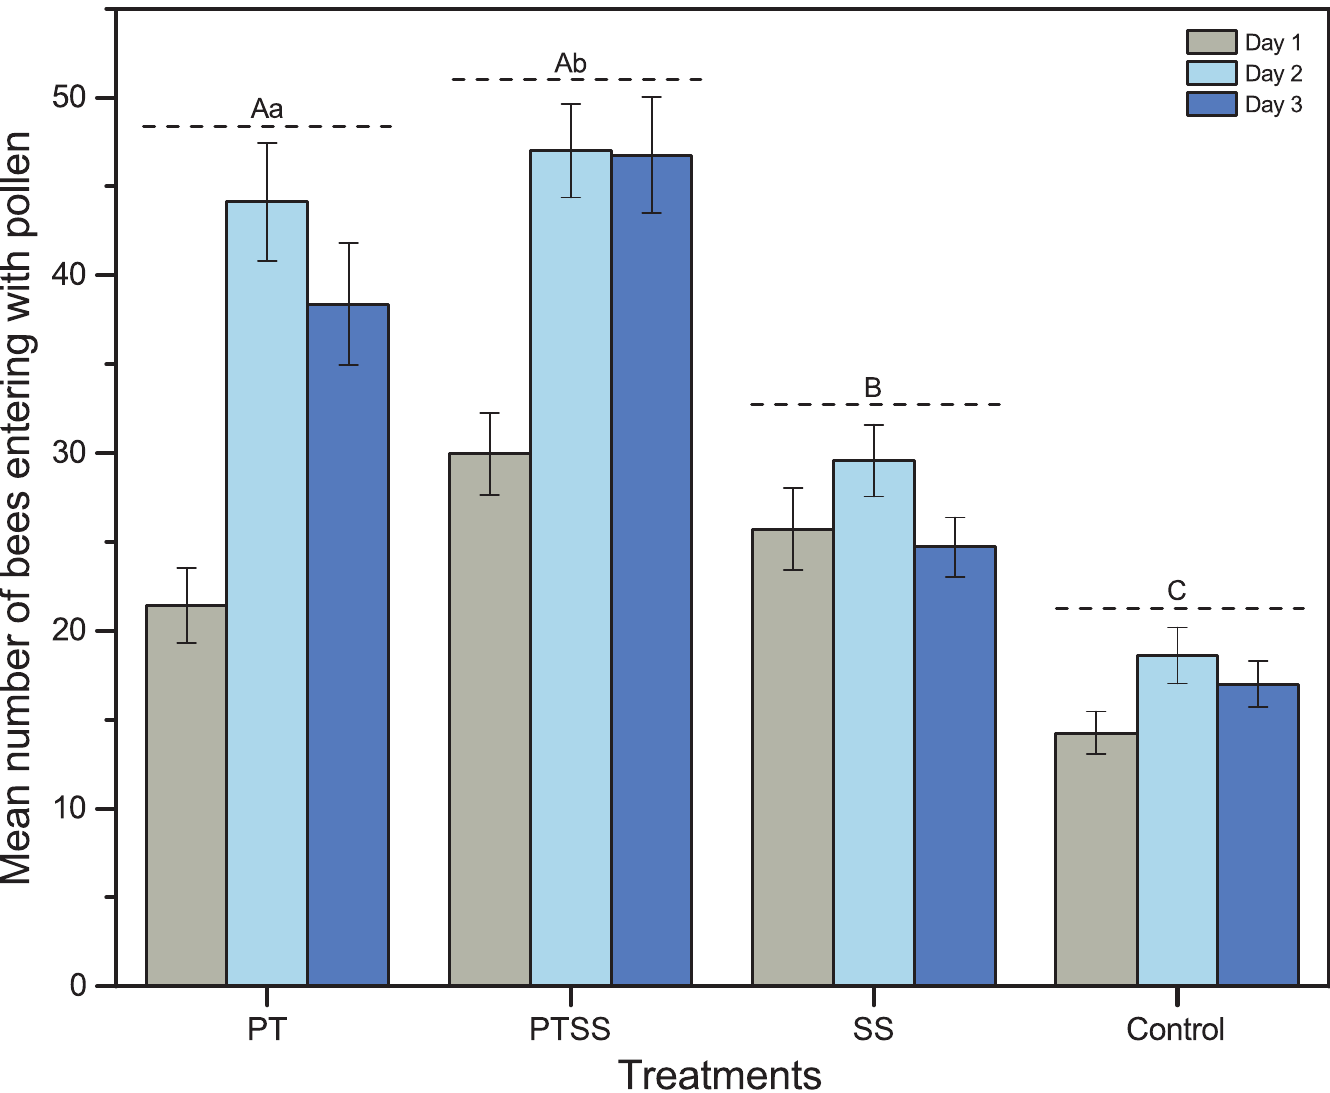
Fig 1. Mean number of honeybees entering with pollen. Bars show the mean number of honeybees (mean ± se) entering with pollen under different treatments (i.e. mean number of pollen foragers returning within 5 min). Plotted data are means and standard errors indicate significant differences. Post hoc testing created the groups that capital letters indicate the significance level P < 0.01 and small letters indicate the significance level P < 0.05.